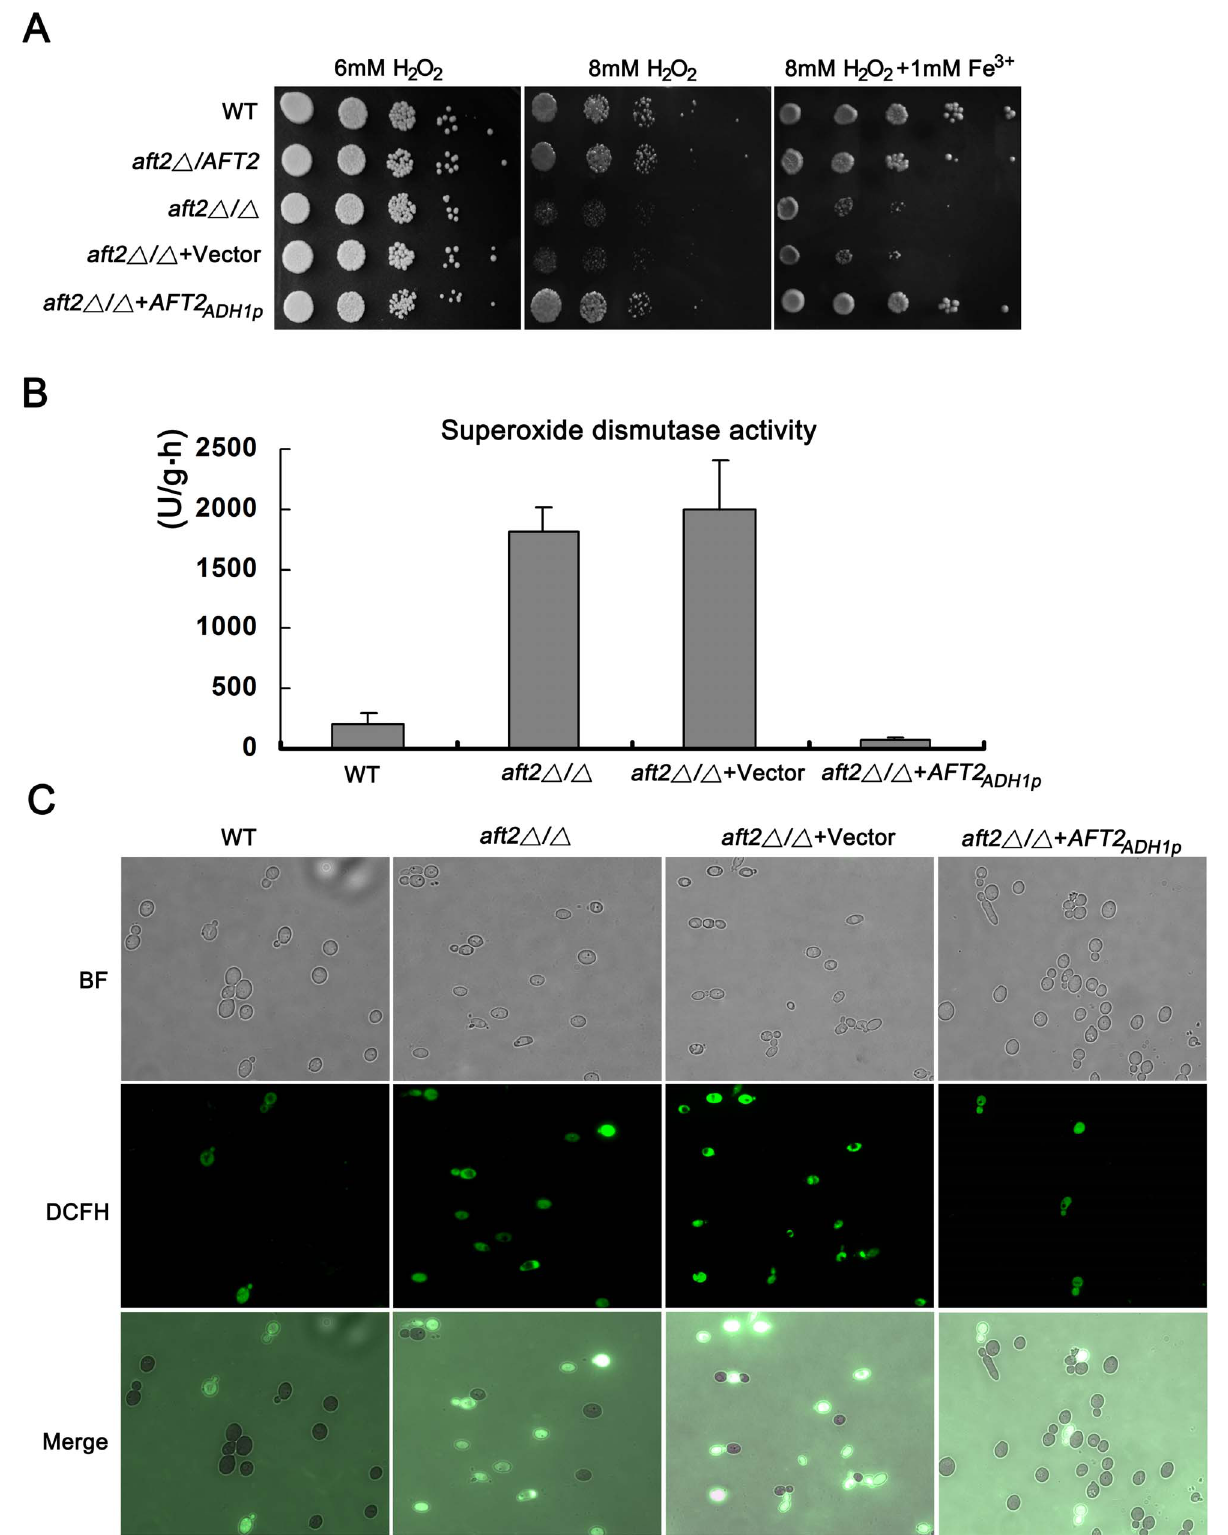
Figure 3. Aft2 is required for the oxidative stress response. (A) Overnight cultures of each strain were resuspended in YPD medium with OD 600 of 0.1. 5 ul of cells in 10-fold serial dilutions were spotted onto solid YPD or YPD + 1 mM Fe 3 + medium that was supplemented with the indicated concentrations of H 2 O 2 . The plates were incubated at 30 u C for 2 days and photographed. (B, C) Reactive oxygen species (ROS) and superoxide dismutase enzymes (SOD) activity were measured as described in Materials and methods.